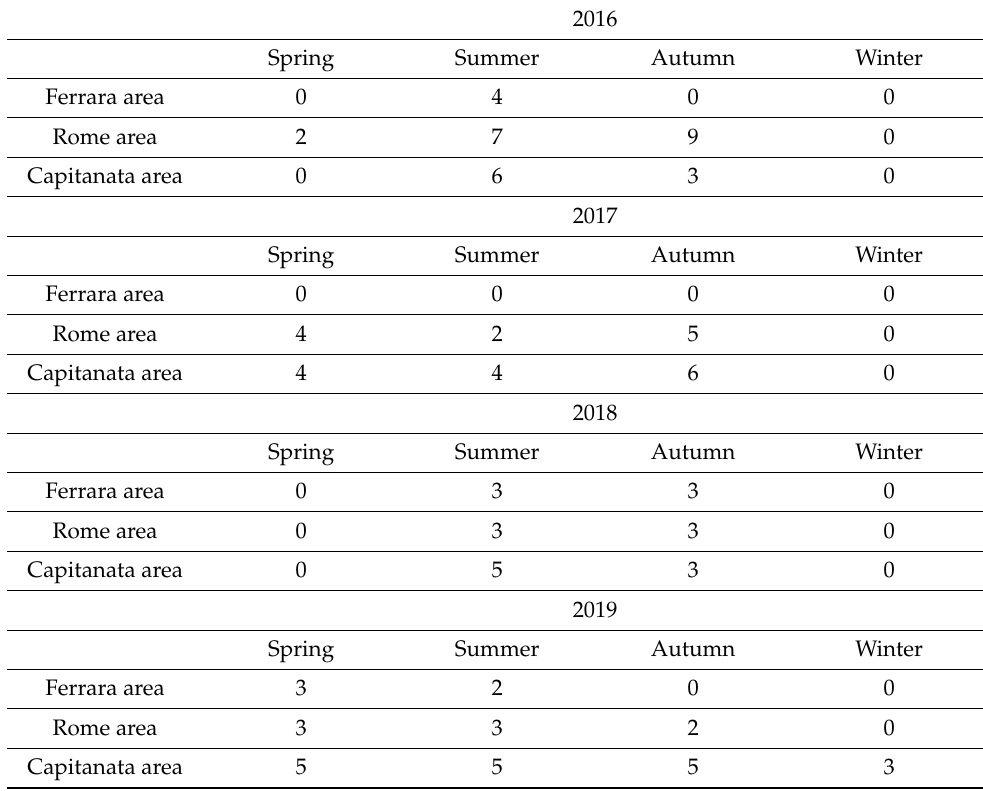
Table 4. Temporal sensitivity analysis: average number of cloud-free bare soil images available per season for Ferrara, Rome, and